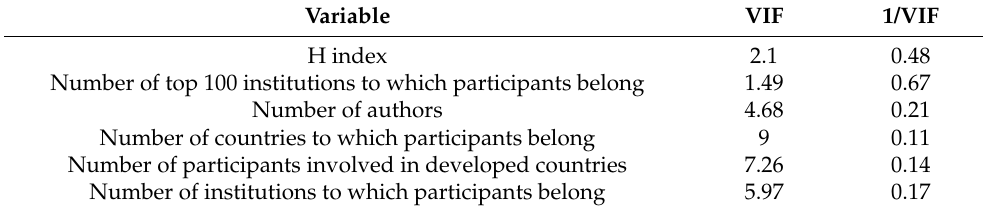
Table 4. Multicollinearity